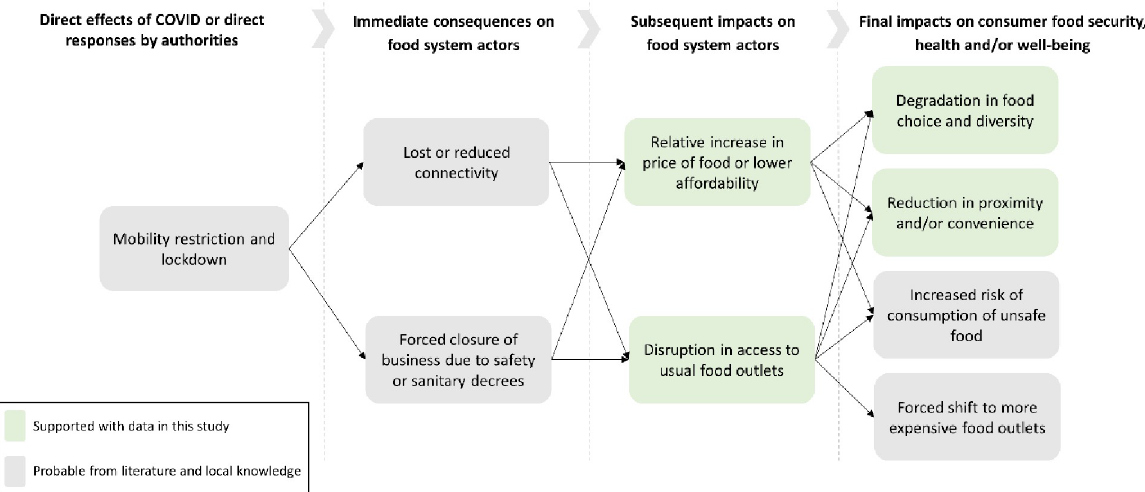
Fig 6. Likely impact pathways for seafood consumers during COVID-19 in West Nusa Tenggara, Indonesia. Pathway categories and flow based on the global literature of empirically derived impact pathways on food systems during COVID-19 by Be´ne´ et al., [20]. Displayed categories are only those relevant for this study context. Boxes colored green reflect impacts supported by the analysis in this study. grey boxes are speculated based on the local knowledge of the authors and literature.